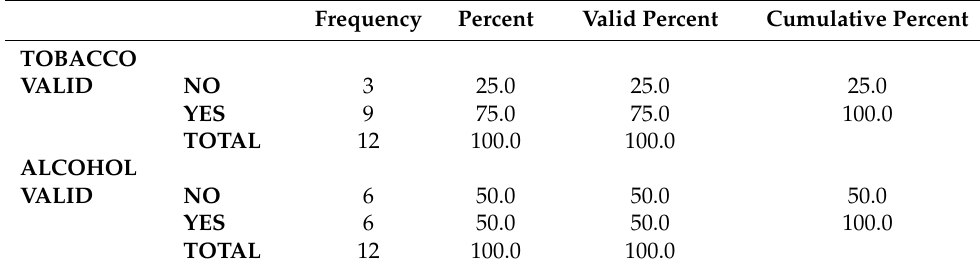
Table 4. Female population and associated risk